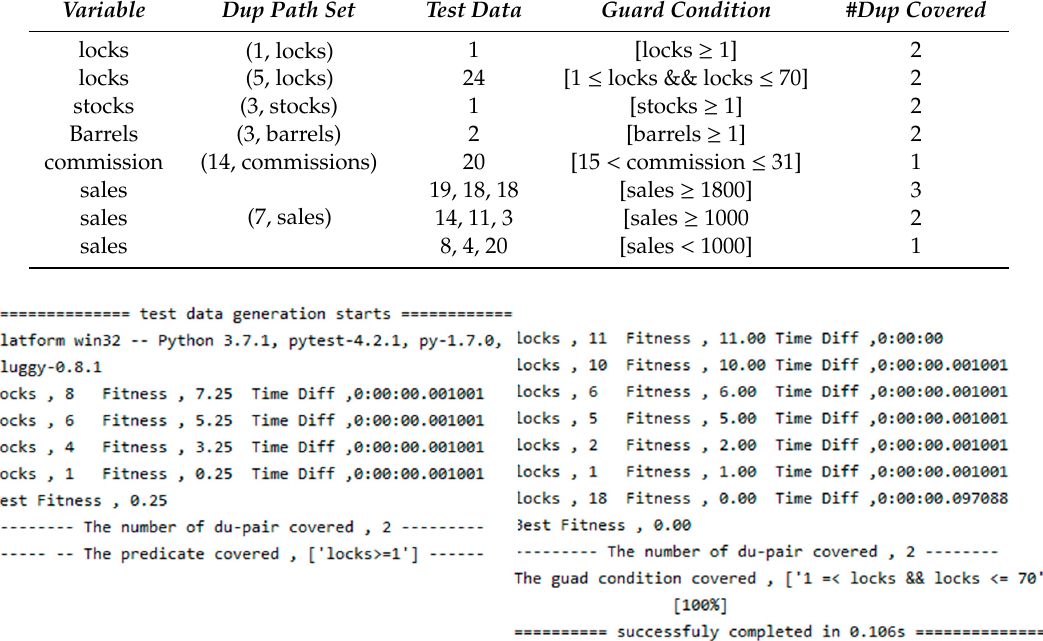
Table 2. The generated test data and associated information.